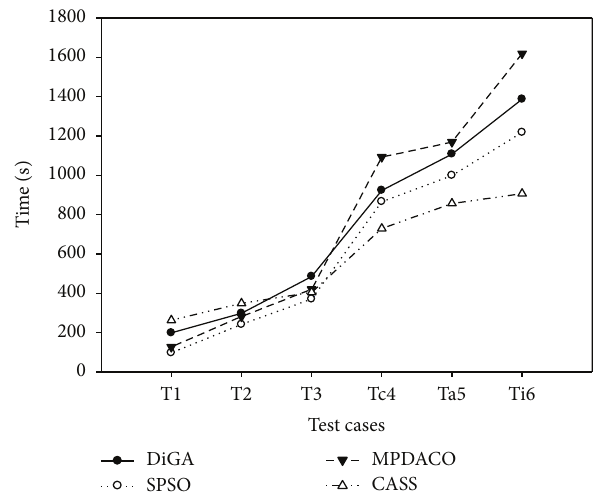
Figure 1: The compare of the time